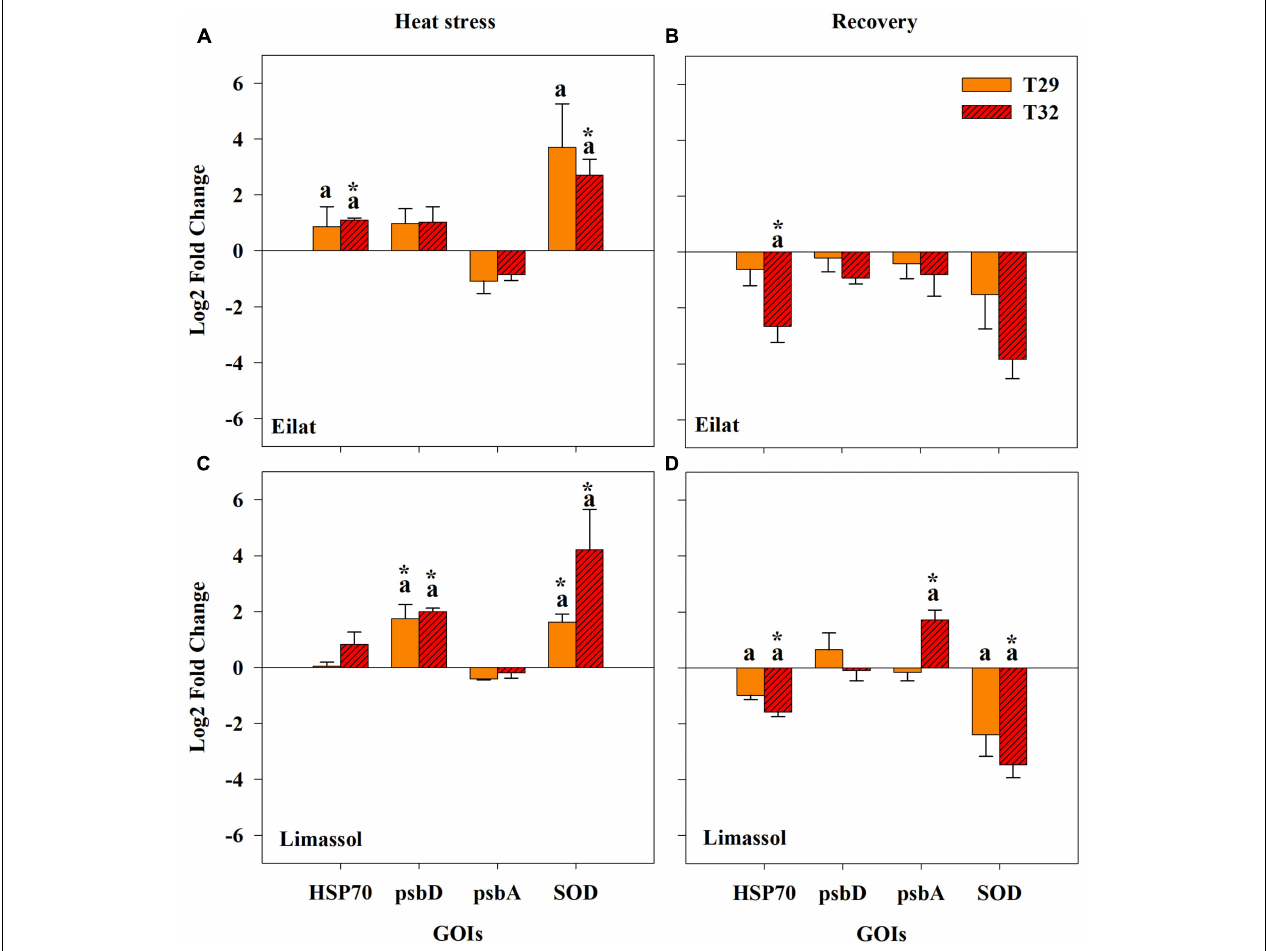
FIGURE 7 | Effects of a simulated heat wave on plant gene expression (log2 scale) in native (A,B) and invasive (C,D) populations of H. stipulacea plants ( n = 3; mean ± SE). Results of pair-wise comparison tests are presented on top of each column: an asterisk ( ∗ ) indicates significant differences between control vs. heated plants ( p < 0.001) and letters represent differences between 29 and 32 ◦ C-heated plants. Shown are expression patterns during the middle of the heat stress (T3; A,C ) and following 24 h after the return to the control temperature (T4; B,D ). Gene abbreviations are found in Table 1